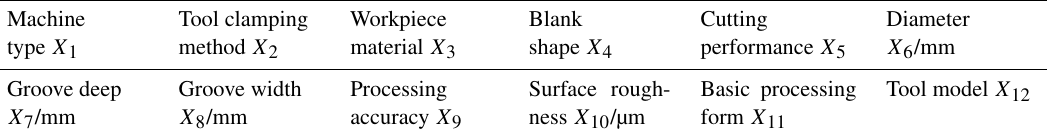
Table 4. Dataset properties.